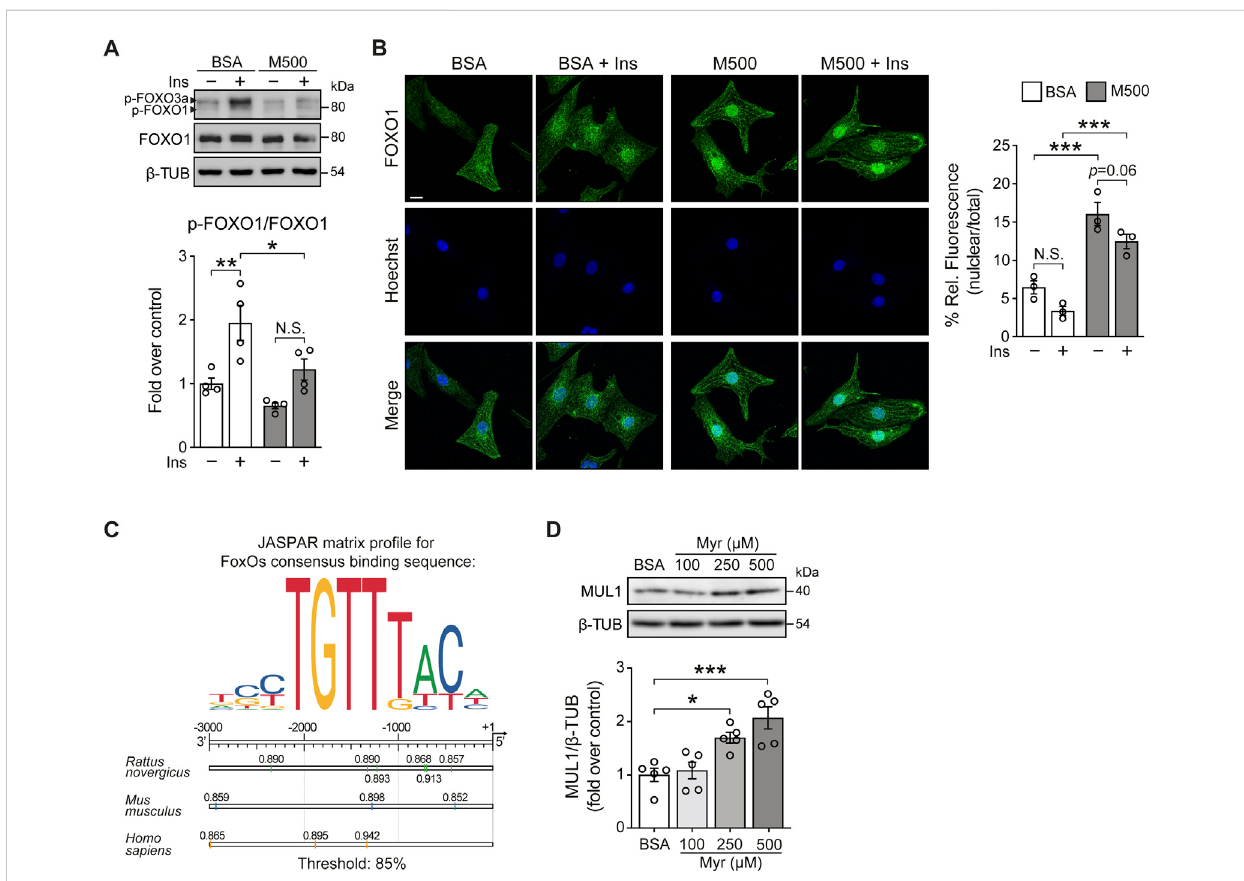
FIGURE 2 Myristate increases Mul1 protein levels in cultured cardiomyocytes. (A) Top : Representative immunoblots of phospho (p)-FOXO1/3a (Thr24/Thr32) andtotalFOXO1fromNRVMtreatedwithBSAormyristate500 μ M(M500)for24 h,unstimulatedorstimulatedwithinsulin10 nMfor15 min. β -TUBULIN wasusedasaloadingcontrol. Bottom :Quanti fi cationofp-FOXO1/FOXO1(n=4). (B) Left :Representativeimmuno fl uorescenceimagesofNRVMtreated withBSAorM500for24h,unstimulatedorstimulatedwithinsulin10 nMfor15 min,usingFOXO1antibodyandtheHoechstnuclearstain.Scalebar: 10 μ m. Right : Quanti fi cation of the relative fl uorescence of the nuclear compartment (nuclear/total fl uorescence), associated with the FOXO1 signal, from 40 – 50 NRVM per experimental condition (n = 3). (C) Top: JASPAR matrix pro fi le used to fi nd FOXO1 binding sites in the Mul1 promoter region. Bottom :Diagram of Mul1 promoter region from rat,mouse,and human,showing thepreciselocalization of thepredicted sequences for FOXO1 binding, with the corresponding relative score, related to the sequence analyzed and matrix utilized. A threshold value of 85% was used. This threshold value establishes searching sequences whose score is greater than or equal to 85% of the best possible score for the motif analyzed. (D) Top : Representative immunoblot of MUL1, detected in cardiomyocytes treated with Myr 100, 250 and 500 μ M, for 24 h. β -TUBULIN ( β -TUB) was used as a loading control. Bottom : Quanti fi cation of MUL1/ β -TUB (n = 5). In all panels: individual data points are shown, and bars represent mean ± S.E.M. Statistical comparisons: * p < 0.05, * p < 0.01 and *** p <